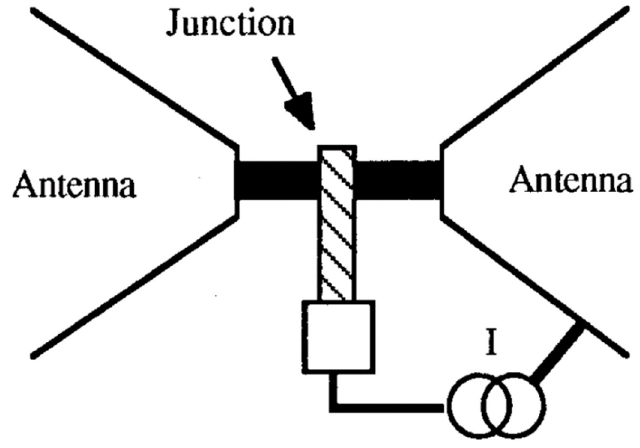
Figure 1. Basic schematics of ANHEB with superconducting antenna directly connected via Andreev junctions to normal metal absorber (black), and NIS junction thermometer connected to current source I.